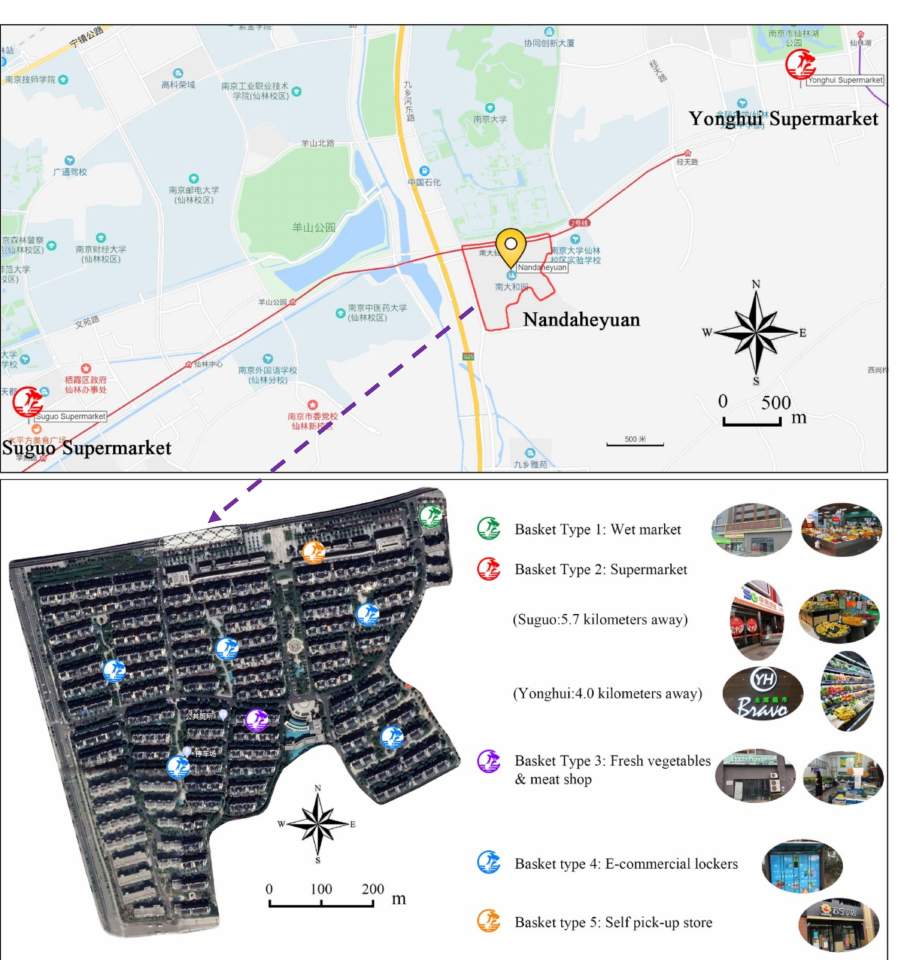
Figure 5. “Vegetable Baskets” plan for a neighbourhood in east